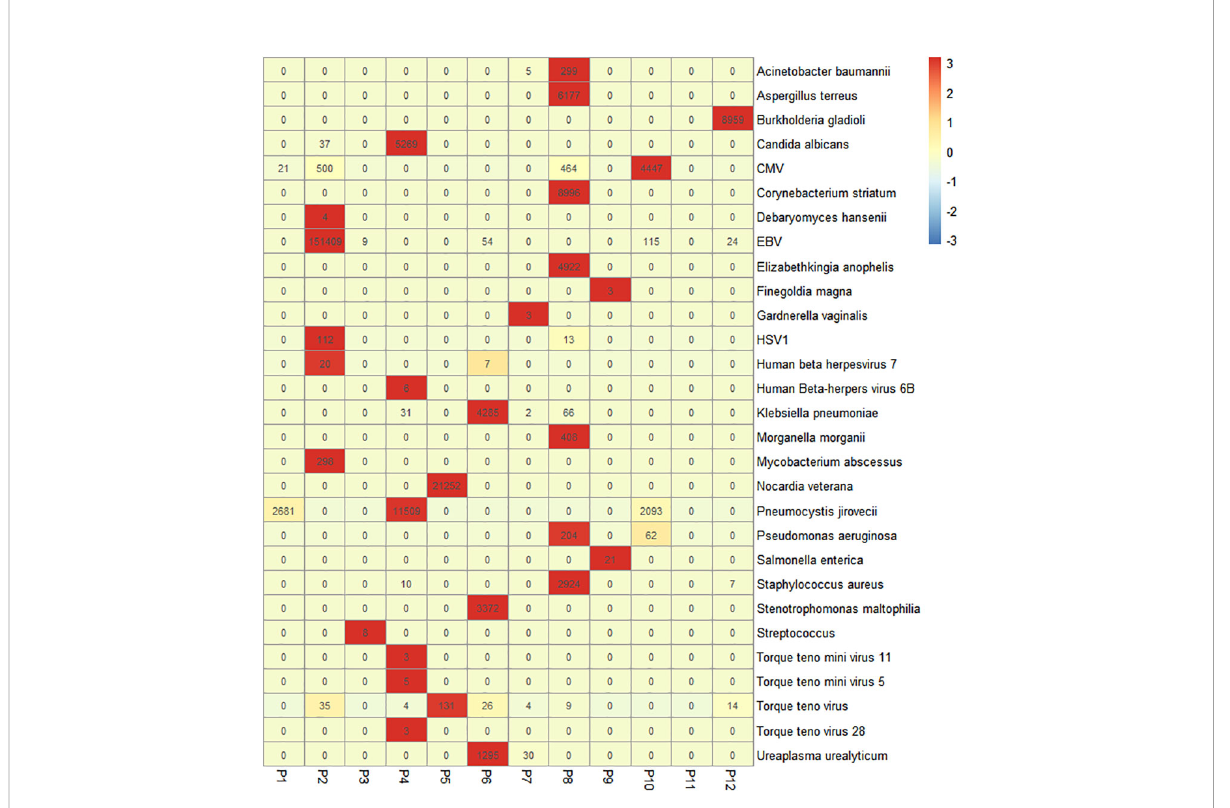
FIGURE 2 Heatmap of the pathogenic microorganism DNA/RNA high-throughput genetic sequencing (PMseq) results in 12 patients. A total of 29 pathogens were identi fi ed from 11 patients (91.67%, 11/12) including 15 bacteria, 4 fungi, and 9 viruses with different abundance. CMV, cytomegalovirus; EBV, Epstein – Barr virus; HSV1, herpes simplex virus 1.